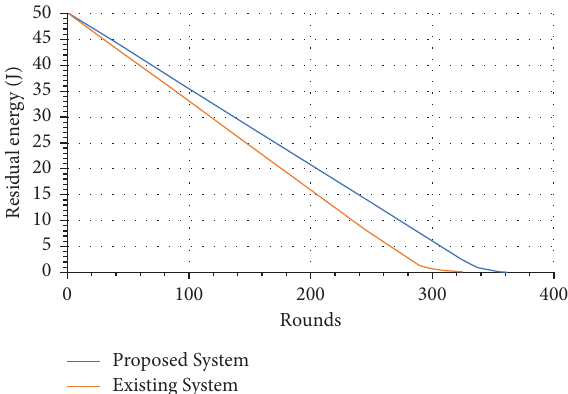
Figure 3: Comparative analysis of residual energy.